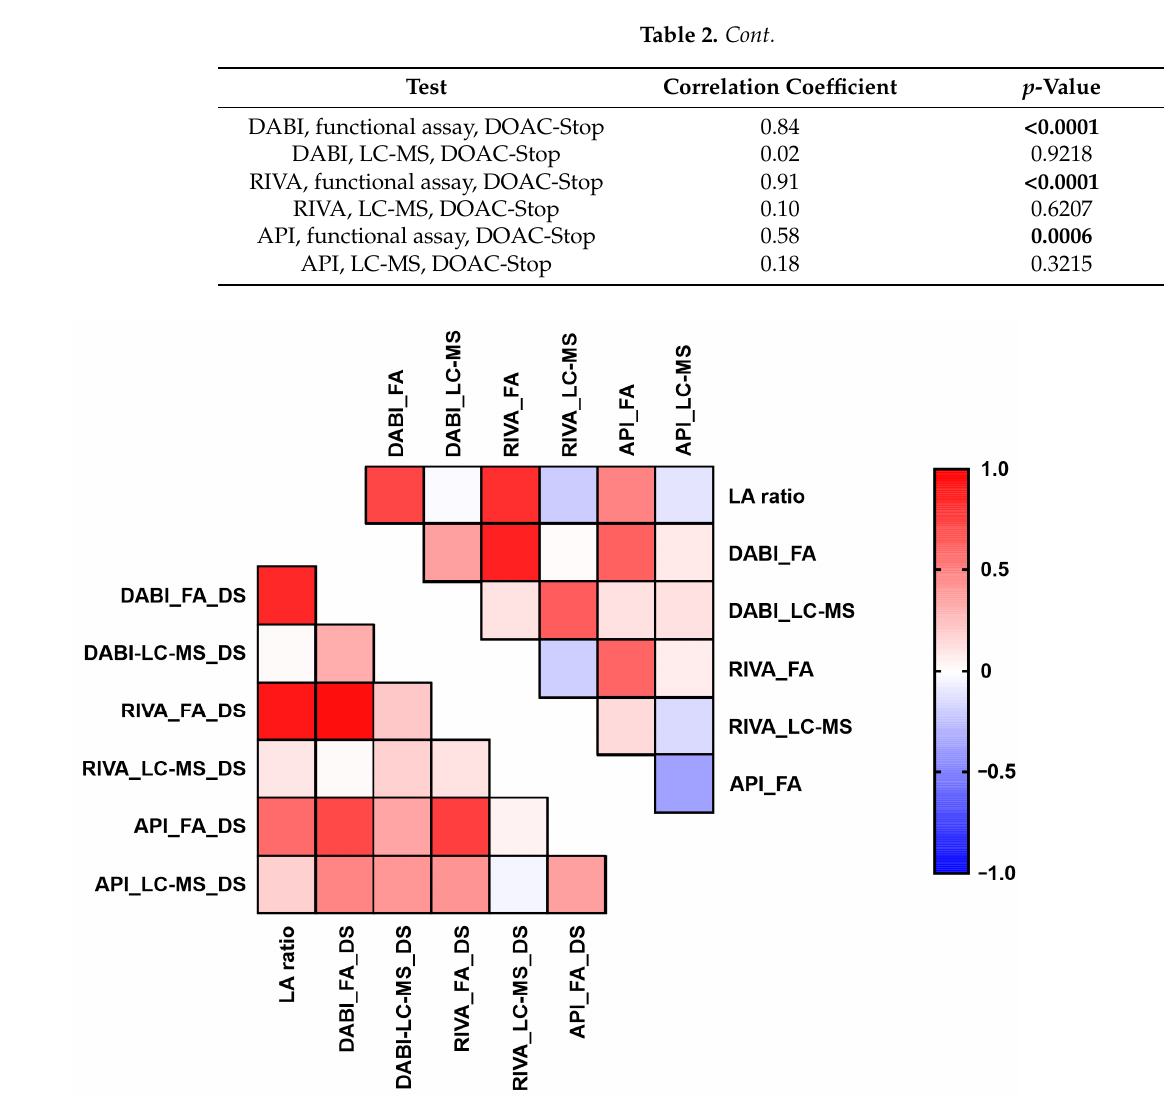
Figure 2. Heatmap of Spearman correlation coefficients of DABI, RIVA and API levels and LA ratio. Abbreviations: DS, DOAC-Stop procedure.